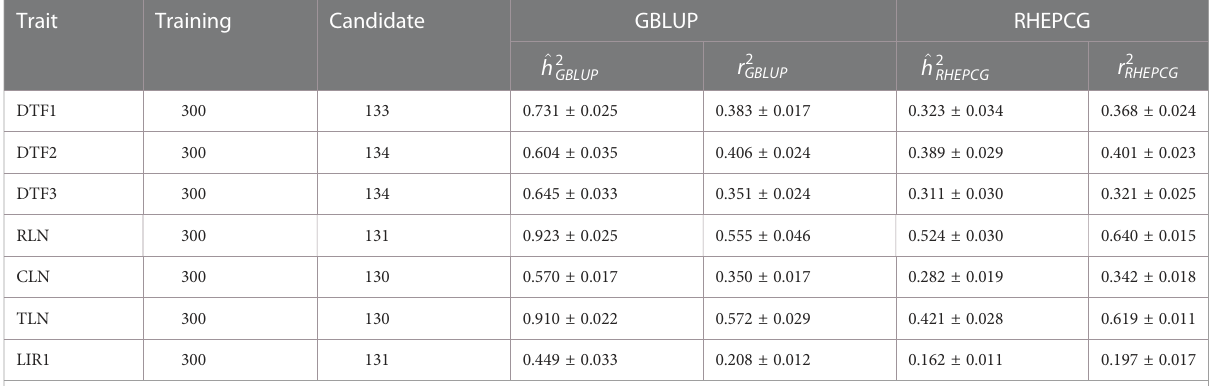
TABLE 5 Comparison of the predictive accuracy between GBLUP and RHEPCG in fi ve traits from the Sorghum bicolor RIL population based on 10 simulations.